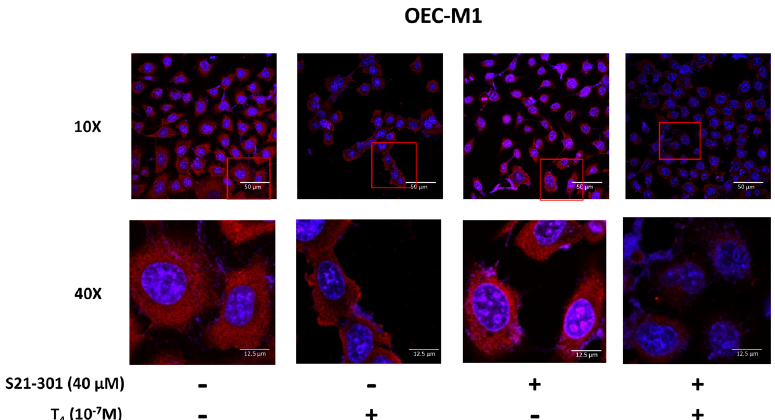
Figure 3. Thyroxine (T 4 )-induced PD-L1 accumulation is activated-STAT3-dependent in human oral cancer OEC-M1 cells. Oral cancer OEC-M1 cells were seeded on a cover glass. Cells were starved for 48 h, fed hormone-stripped serum-containing medium, and then treated with T 4 in the presence and absence of 40 µ M S31-201 for another 24 h. Cells were fixed for confocal microscopic analysis of PD-L1 accumulation (red color). Nuclei were counterstained with DAPI (blue color). The field of view of the red square is magnified for easy viewing.